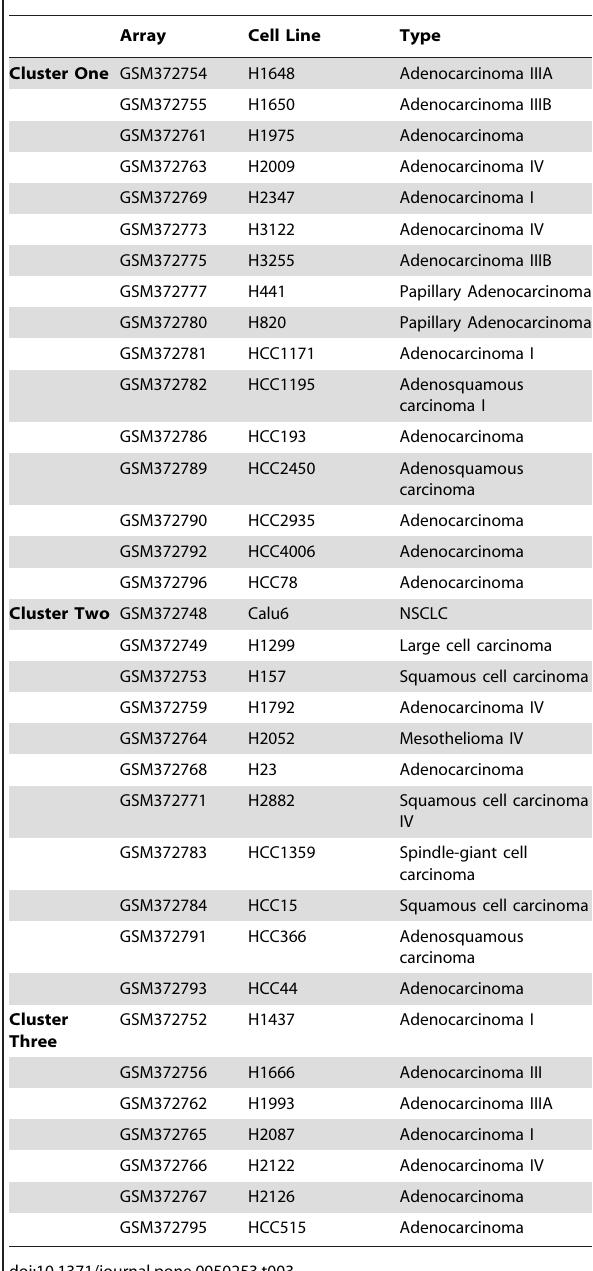
Table 3. The three identified clusters and their annotations.